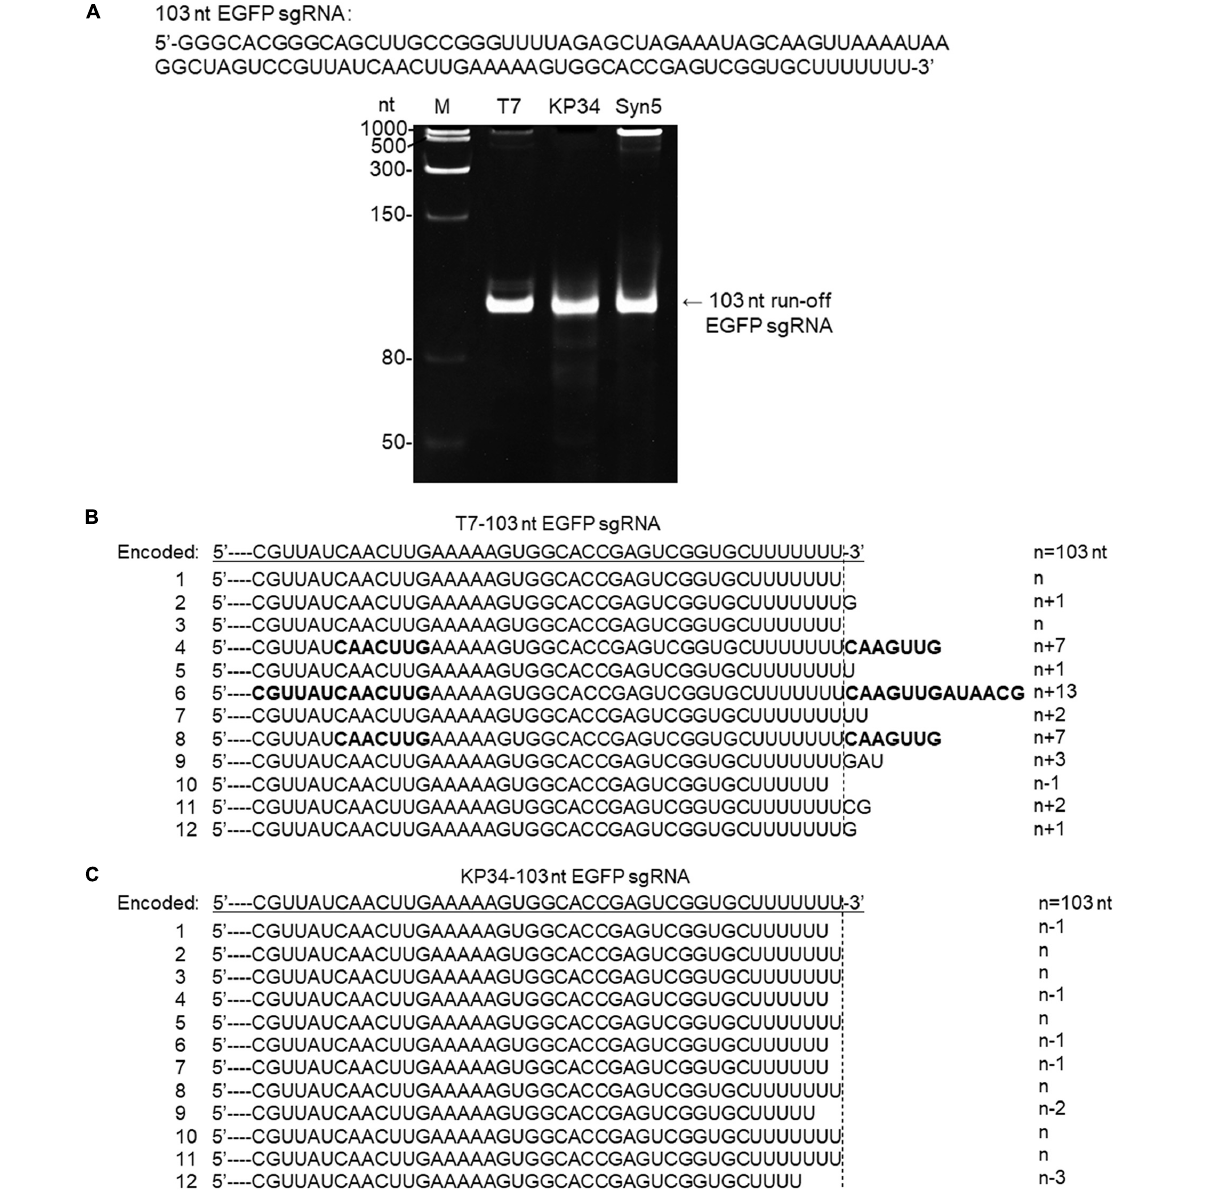
FIGURE 4 | Synthesis of an sgRNA by T7 and KP34 RNAP. (A) The sgRNA sequence is shown at the top of the gel. The three DNA templates containing the same coding sequences for the sgRNA under the control of either a T7 promoter, a KP34 strong promoter, or a Syn5 promoter were incubated with 0.2 µ M T7 RNAP, 1 µ M KP34 RNAP, or 1 µ M Syn5 RNAP, respectively. Incubation with KP34 and T7 RNAP was at 37 ◦ C for 1 h and incubation with Syn5 RNAP was at 24 ◦ C for 1 h. Reaction products were separated by a 12% TBE native gel and then stained with ethidium bromide. M: ssRNA Ladder. (B) 3 (cid:48) -RACE analysis of the 3 (cid:48) termini of T7 RNAP transcripts. 3 (cid:48) termini of obtained sequences were aligned and shown. A dotted line cut indicates the precise terminus encoded by DNA template and number of extended or missing nt is shown as n + x or n–x. Bold sequences indicate complementary sequences in each RNA resulted from extension of possible 3 (cid:48) self-primed structures. (C) Similar as B, 3 (cid:48) -RACE analysis of the 3 (cid:48) termini of KP34 RNAP